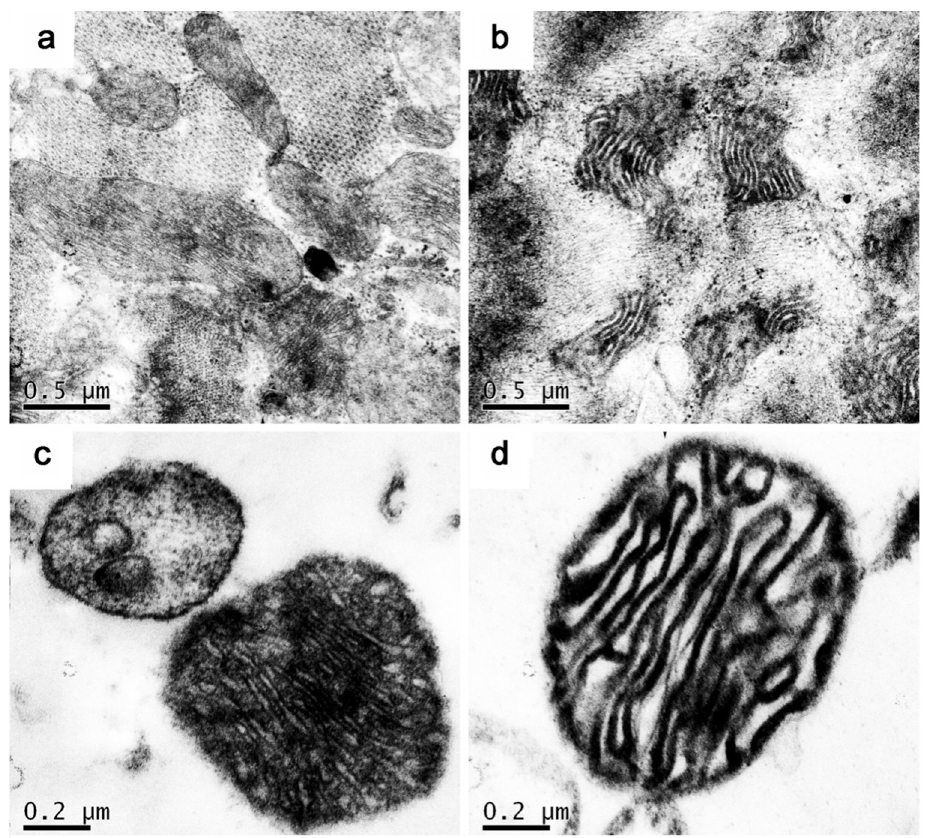
Figure 3. Ultrastructure observation of myocardial mitochondria in adult and aged Tibetan sheep. Note: ( a , b ): Adult and aged Tibetan sheep myocardial mitochondria, bar = 0.5 μ m. ( c , d ): Mitochondria isolated from adult and aged Tibetan Sheep myocardium, bar = 0.2 μ m.